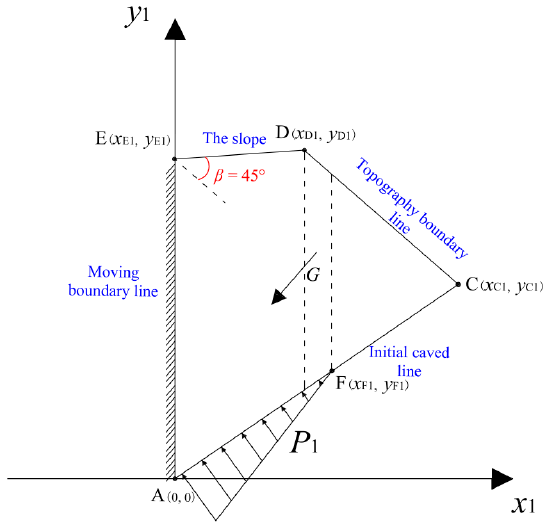
Figure 7. The mechanical model after coordinate transformation.